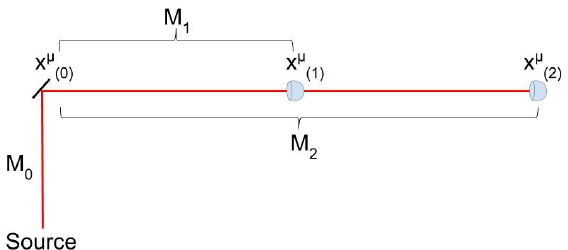
Figure 2. A photon travels according to a k µ -space map M 0 , from a source to a mirror, and is then redirected onto either a path described by map M 1 or a path described by map M 2 . Each of these is a unique distribution in k µ -space due to its unique endpoints, x µ between M 1 and M 2 is made by inserting or removing the detector at x µ